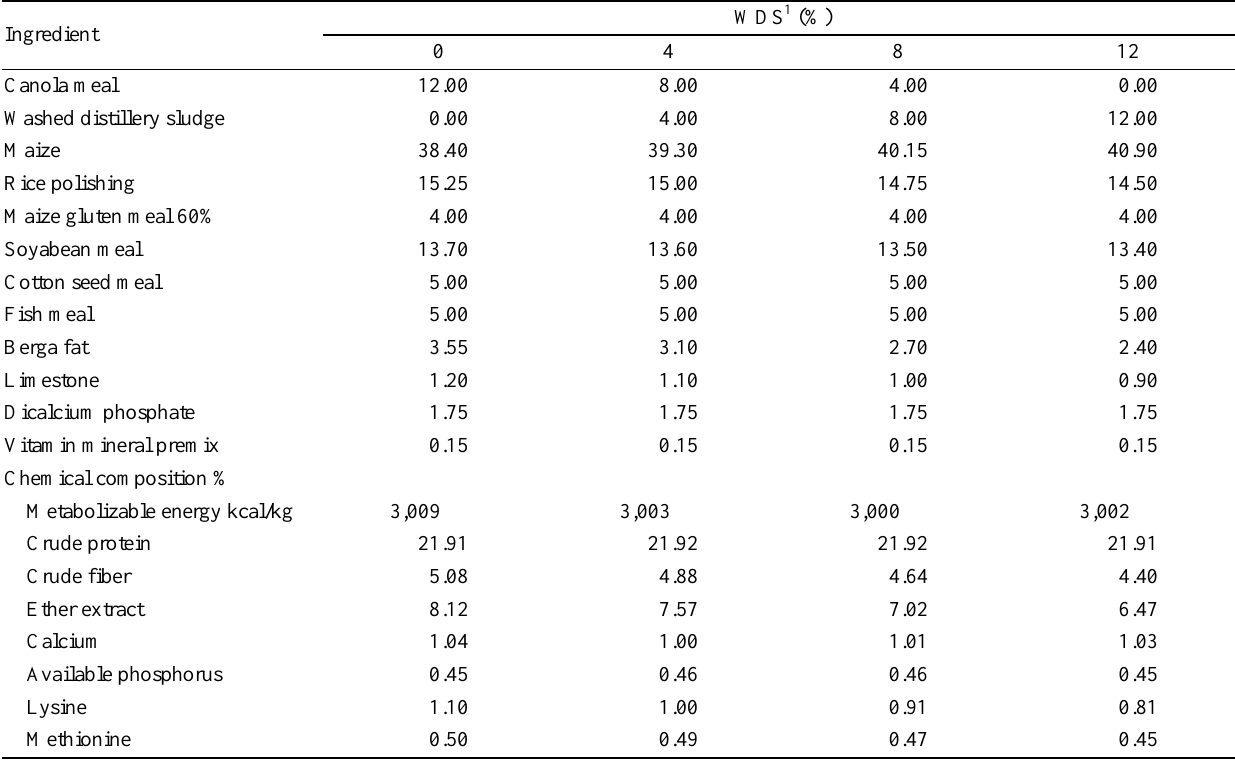
Table 3. Percent ingredients and nutrient composition of broiler starter diets (0-4 wk)